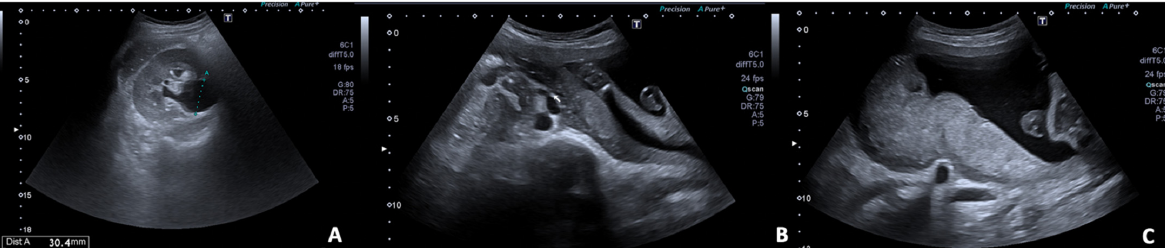
Figure 6. US B-mode scans in a pregnant woman during the third trimester. ( A ) Axial image of the right kidney shows a regular cortical-medullary pattern and physiological dilatation of renal pelvis; ( B ) also the lumbar tract of the right ureter is dilated. ( C ) Exploration of pelvis detects increase in size of the uterus with compression effect on the surrounding structures.